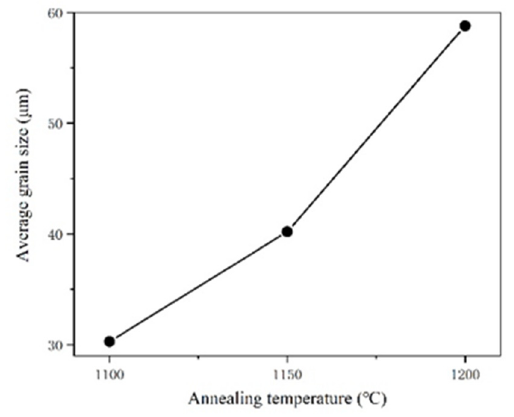
Figure 4. Relationship between annealing temperature and average grain size.